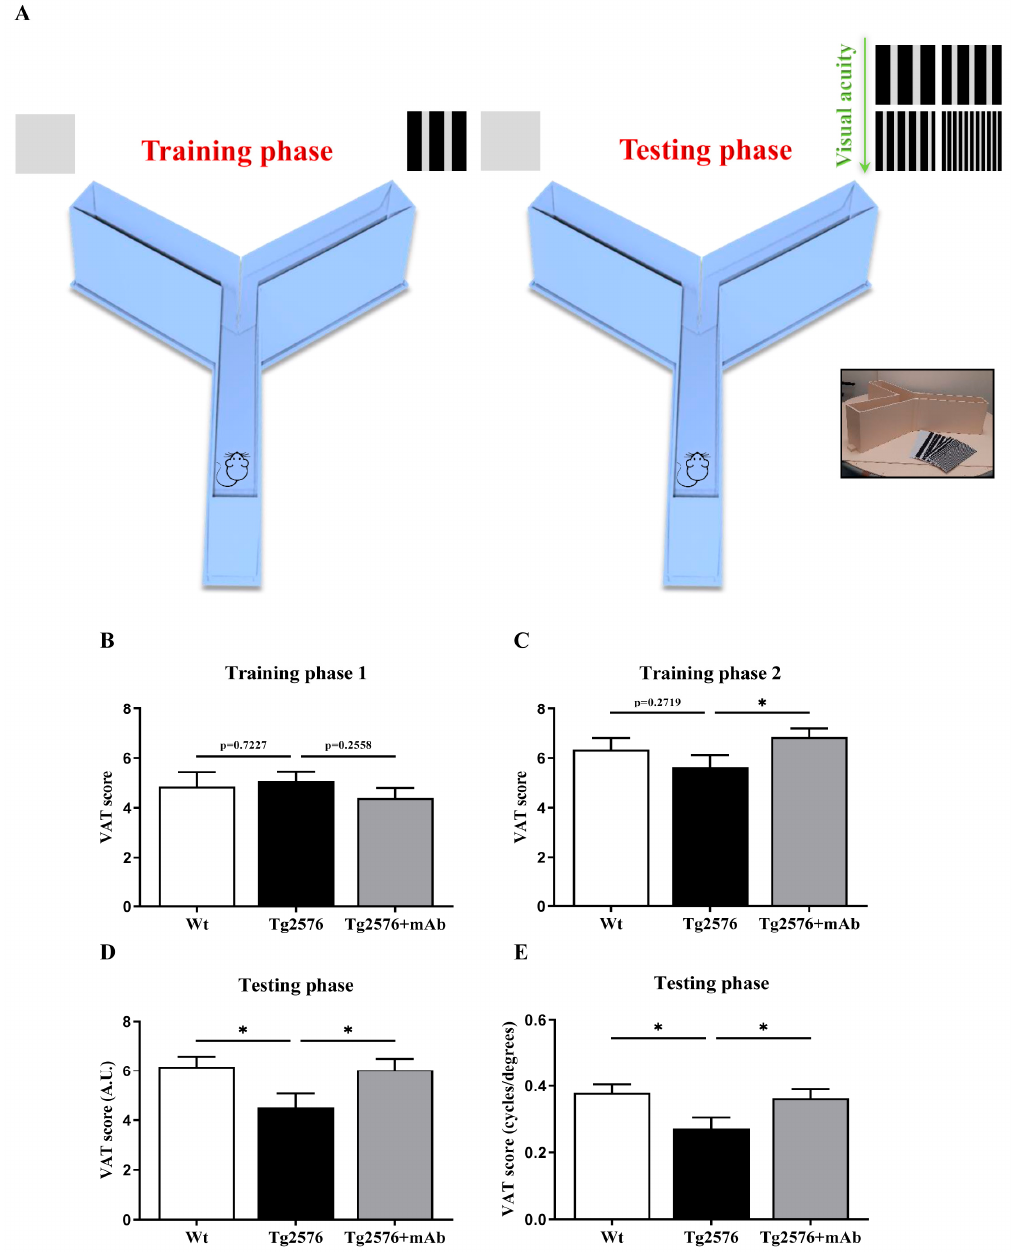
Figure 2. The low visual acuity of Tg2576 AD mice is significantly improved following 12A12mAb immunization. ( A ) Schematic components of the visual acuity testing apparatus. ( B – E ) Male Animals (n = 33) from three experimental groups (littermate wild-type = 10, vehicle-treated Tg2576 = 11, Tg2576+mAb = 12) were tested for their visual acuity in the Prusky’s test, as described